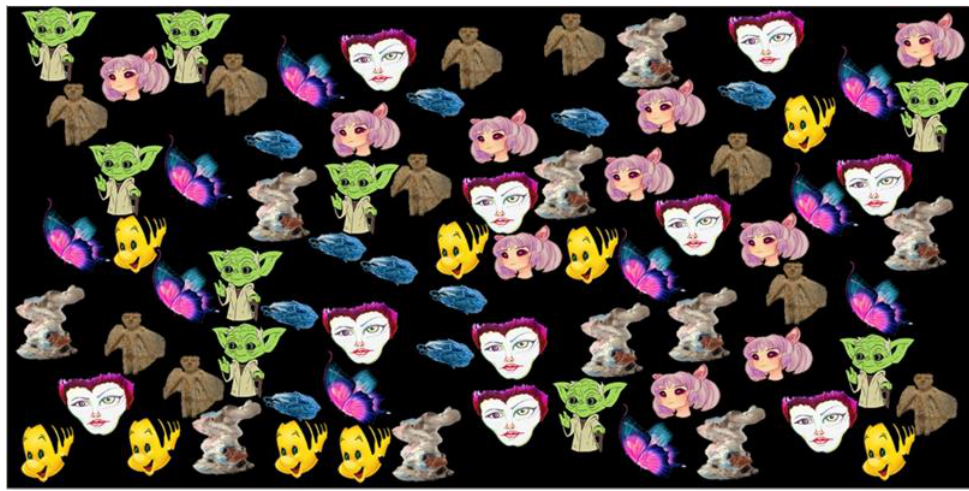
Figure 20. Solution found by the ILS algorithm when inserting 71 pieces for the A3 instance, consuming 4 h of processing time.